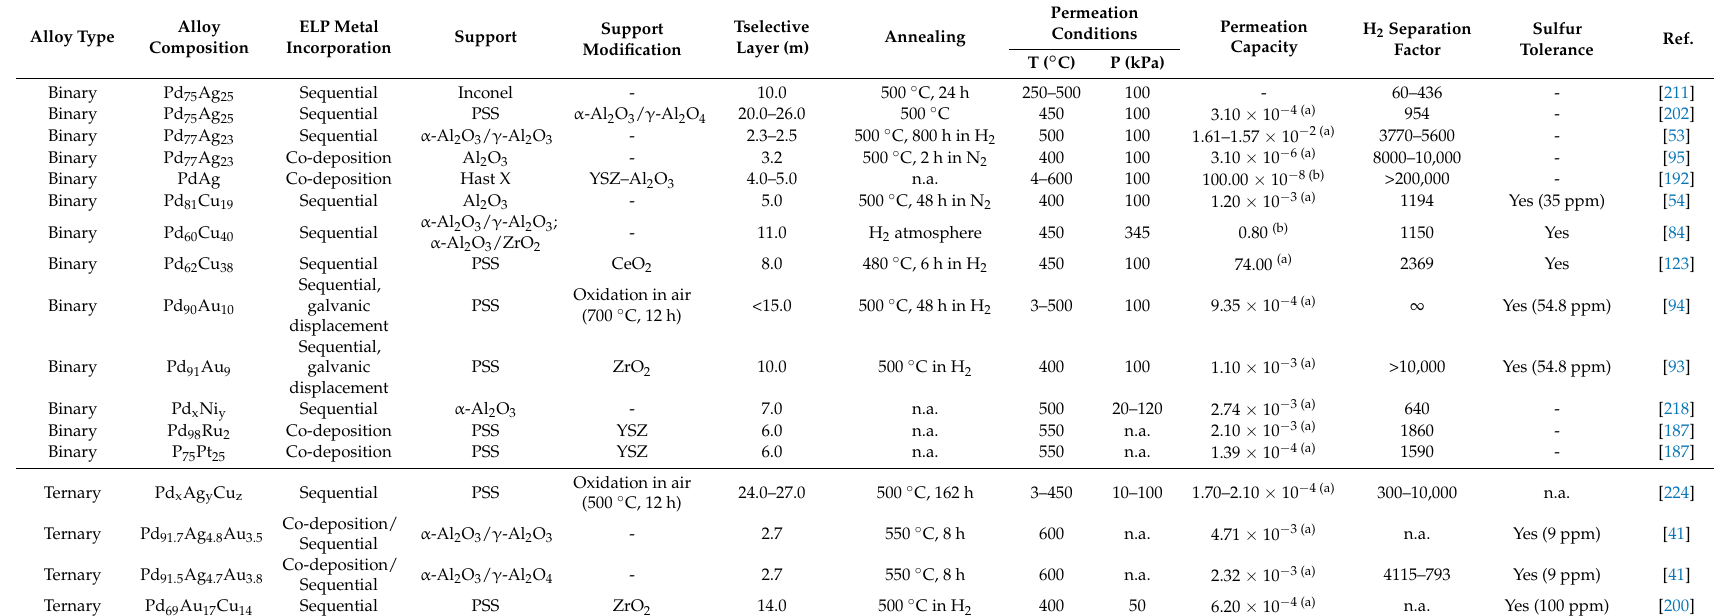
Table 4. Recent advances on preparation of Pd-based